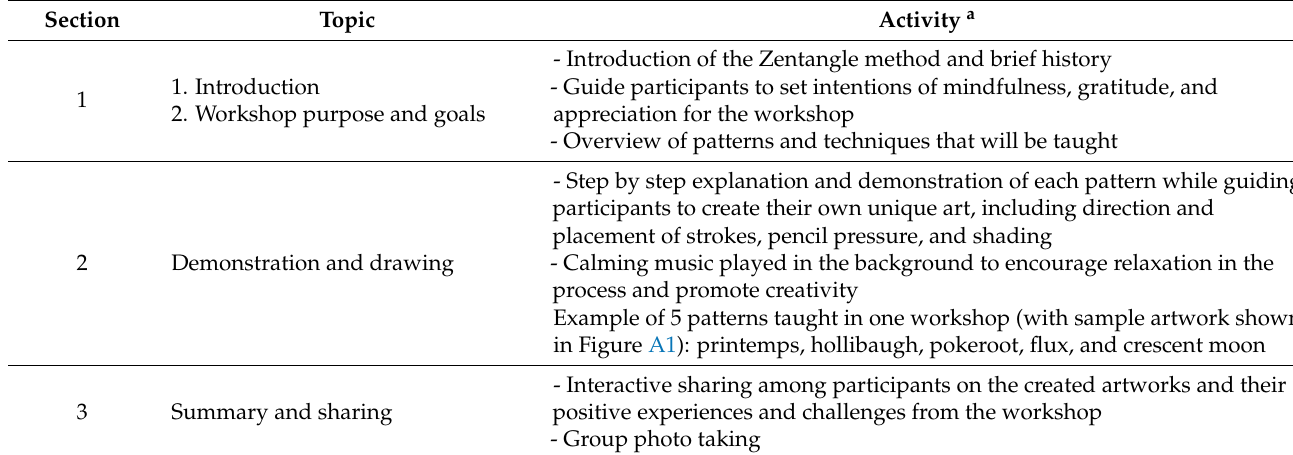
Table 1. Overview and structure of a Zentangle workshop.